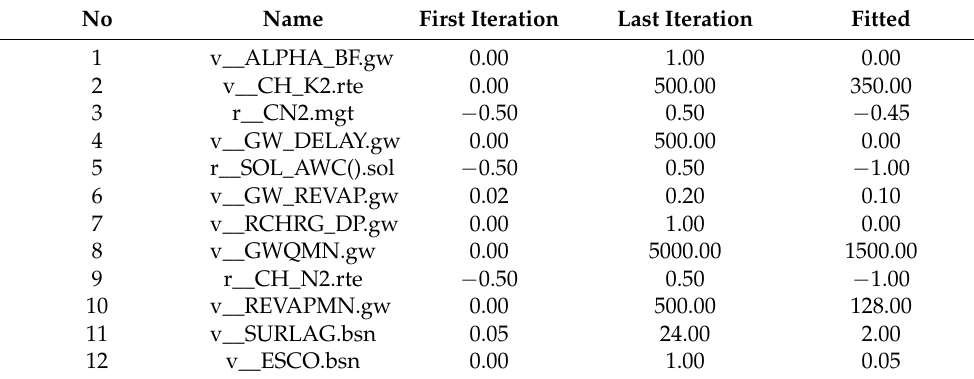
Table 4 indicates that the baseflow alpha-factor (ALPHA_BF), initial SCS runoff Curve Number for moisture condition II value (CN2) and effective hydraulic conductivity in main channel alluvium (CH_K2) are among the most sensitive parameters for daily streamflow calibration, which is similar to the previous monthly scale calibration in KRB [23,38]. ALPHA_BF shows the baseflow response to changes in recharge, CN2 represents a function of the soil permeability, land use and soil water condition, while CH_K2 adjusts the relationship of water exchange from groundwater to river [60,61]. Table 4. Final SWAT performance rating as recommended by Moriasi